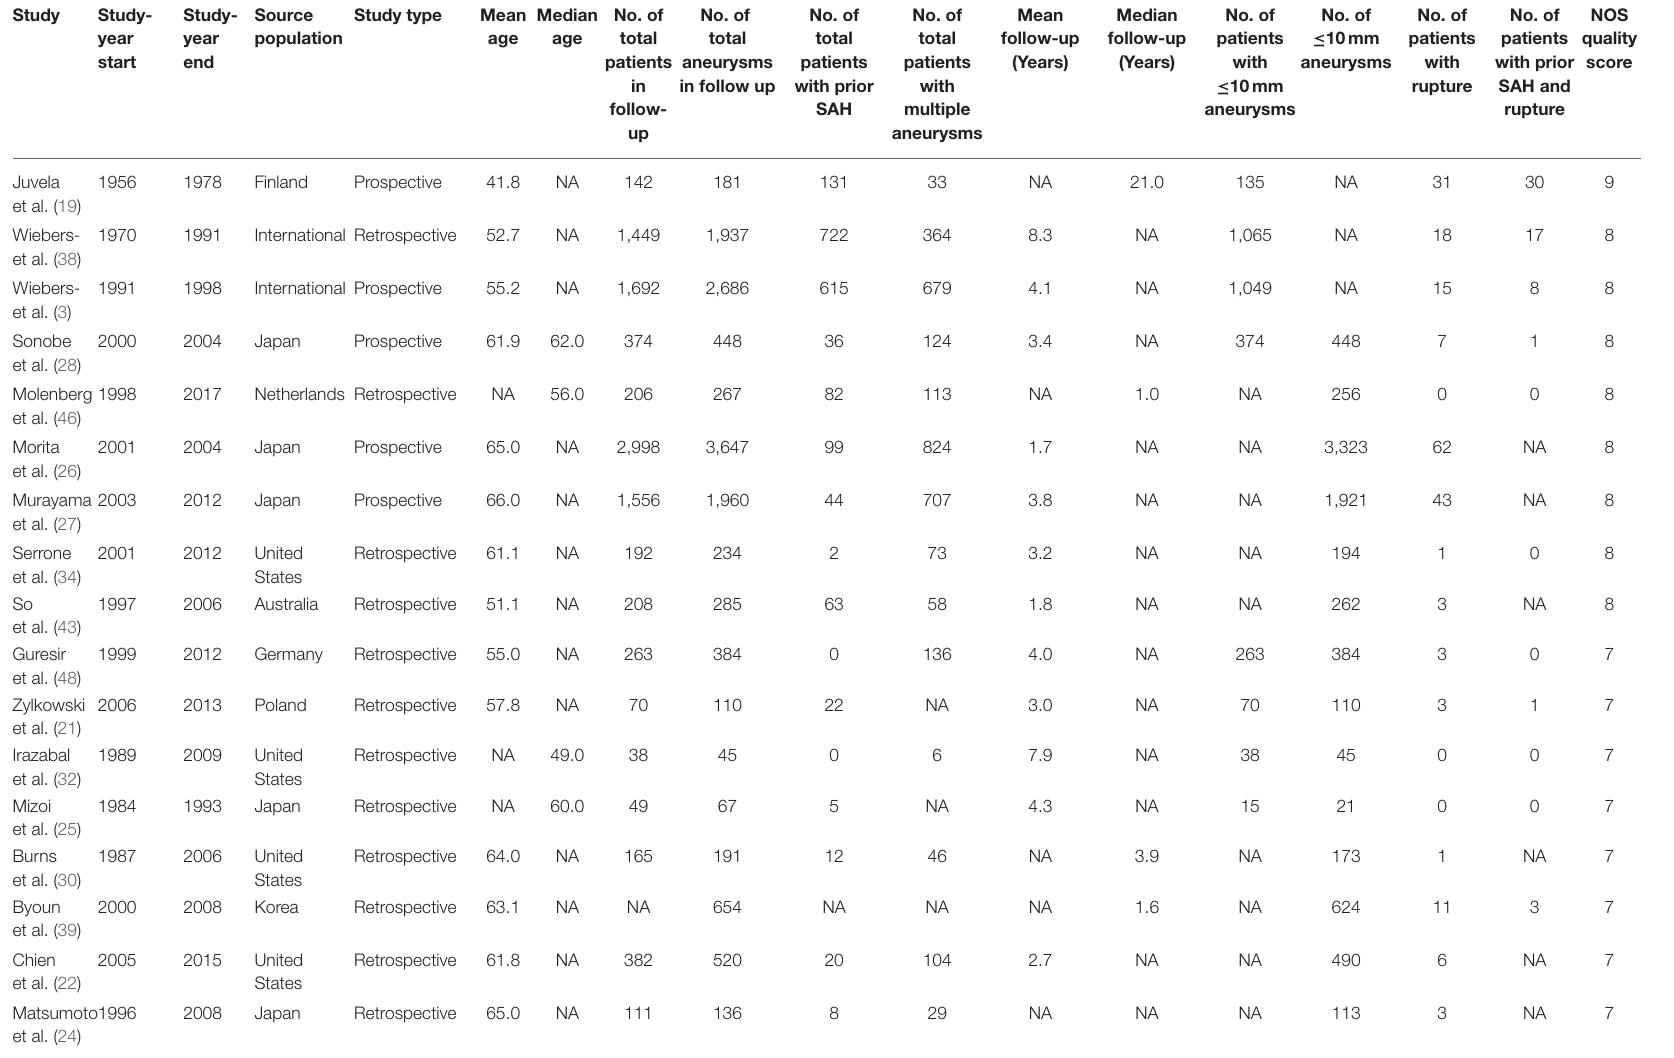
TABLE 1 | Baseline study